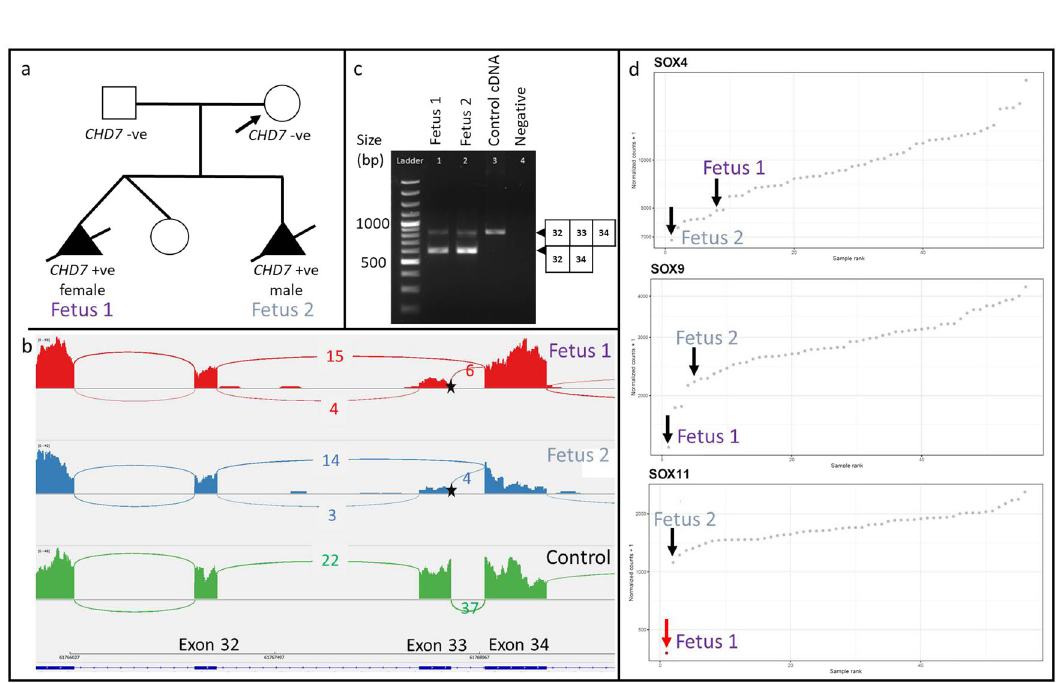
Fig. 3 Family 1 with the CHD7 splicing variant NM_017780.4: c.7164 + 1 G > A. a Pedigree for family 1. b Sashimi plot from integrative genome viewer (IGV) showing the skipping of exon 33 with no alternative splice site in intron 33 for both affected fetuses in comparison with a control. Only one (upper) line extended from exon 32 to 34. The location of the variant is shown with a star. c RT-PCR results with primer pairs spanning exons 32 to 34 showing the expected size of 827 bp. The expected size for the exon 33 deletion = 600 bp, demonstrating a heterozygous skipping of exon 33 in fetuses 1 and 2. The square boxes on the right indicate the exon number. d Expression rank plots for three genes of the SOX family. The X-axis represents all 52 AF cells, ranked in ascending order of the normalized read counts in the corresponding gene. The Y-axis represents the normalized read counts. NM_017780.4:c.7164 + 1 G > A in CHD7 could be affecting the expression of downstream genes such as SOX4 , SOX9 and SOX11 , as these genes were expressed less in fetuses 1 and 2 when compared to all 52 samples. The red dot/arrow indicates aberrant expression of that SOX11 (FDR ≤ 0.05) in fetus